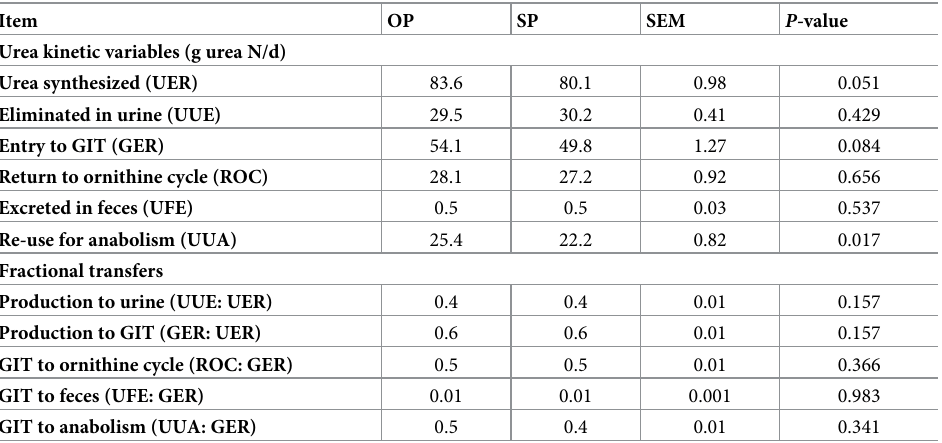
Table 4. Evolution of urea-N kinetics in calves fed SP and OP. Item